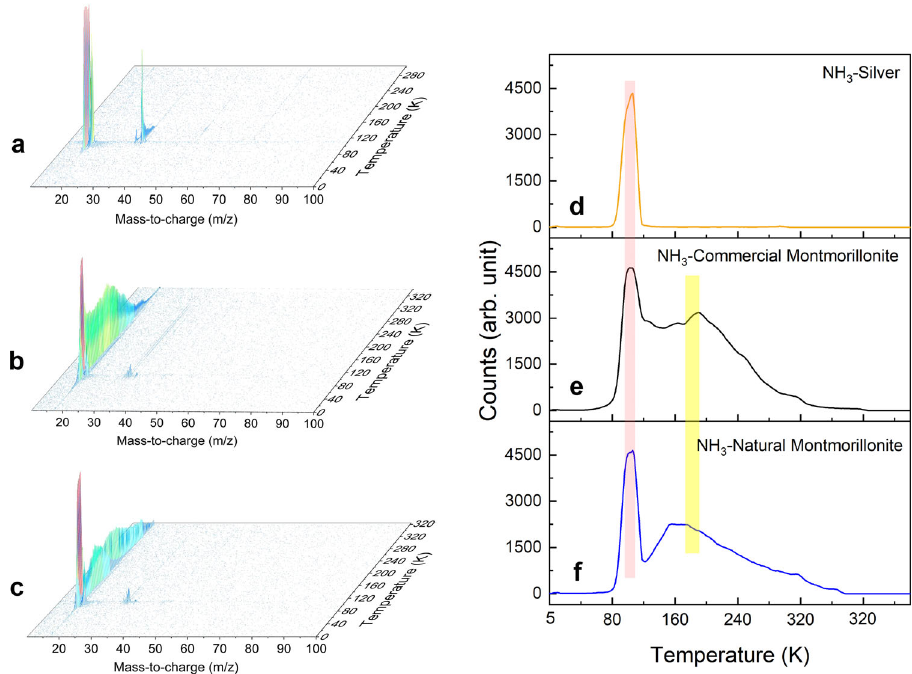
Fig. 2 PI-ReTOF mass spectra measured during the TPD (temperature programmed desorption) phase at a photoionization energy of 10.49 eV. 3D mass spectra of subliming molecules from the surface of ( a ) silver substrate, ( b ) commercial and ( c ) natural montmorillonite. TPD pro fi les of ammonia measured at mass-to-charge ratio (m/z) of 17 in the mass spectra of ammonia coated ( d ) silver, ( e ) commercial montmorillonite and ( f ) natural montmorillonite. The pink and yellow color bars indicate fi rst and second sublimation events respectively. Temperature increase was halted at 320 K till all the molecules sublimed.